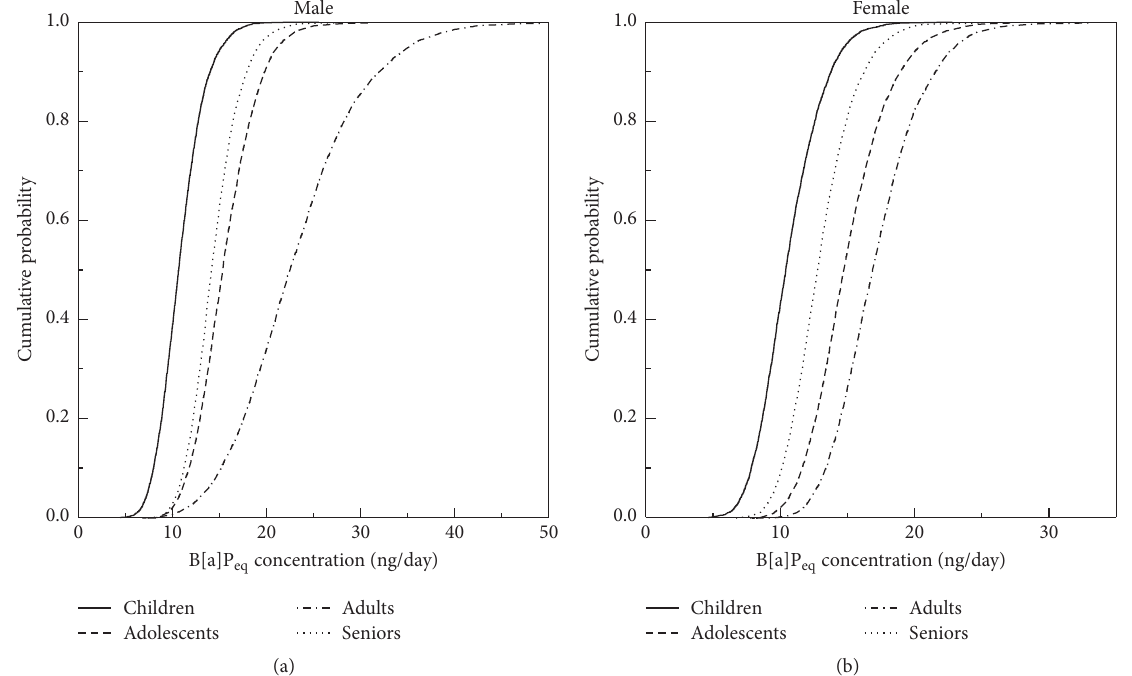
Figure 3: Probability distributions of daily inhalation B [ a ] P eq exposure in PM 10 in summer in Nanjing.